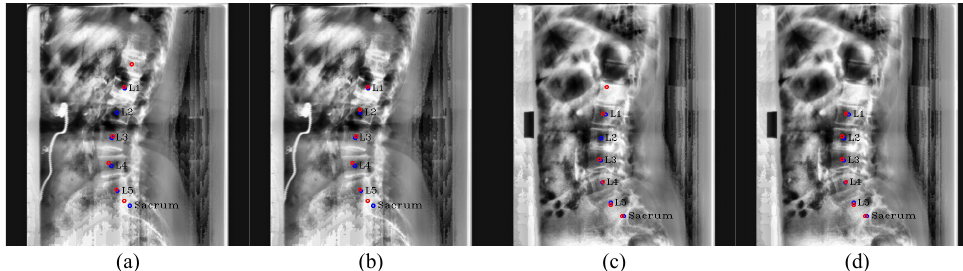
Figure 6. Post-processing results. ( a , c ) are the resulting images before performing post-processing, and ( b , d ) are the resulting images after performing post-processing on ( a , c ), respectively. The red circles denote the predicated centers of L1, L2, L3, L4, L5, and the sacrum in order from the top, and the blue circles and labels denote the ground truth of the center of each vertebra.